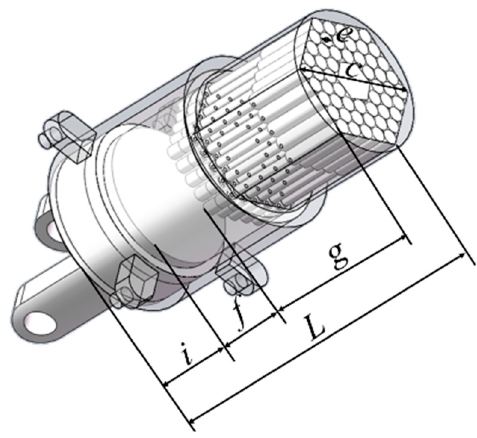
Figure 13. Structural parameters of the universal wrench.